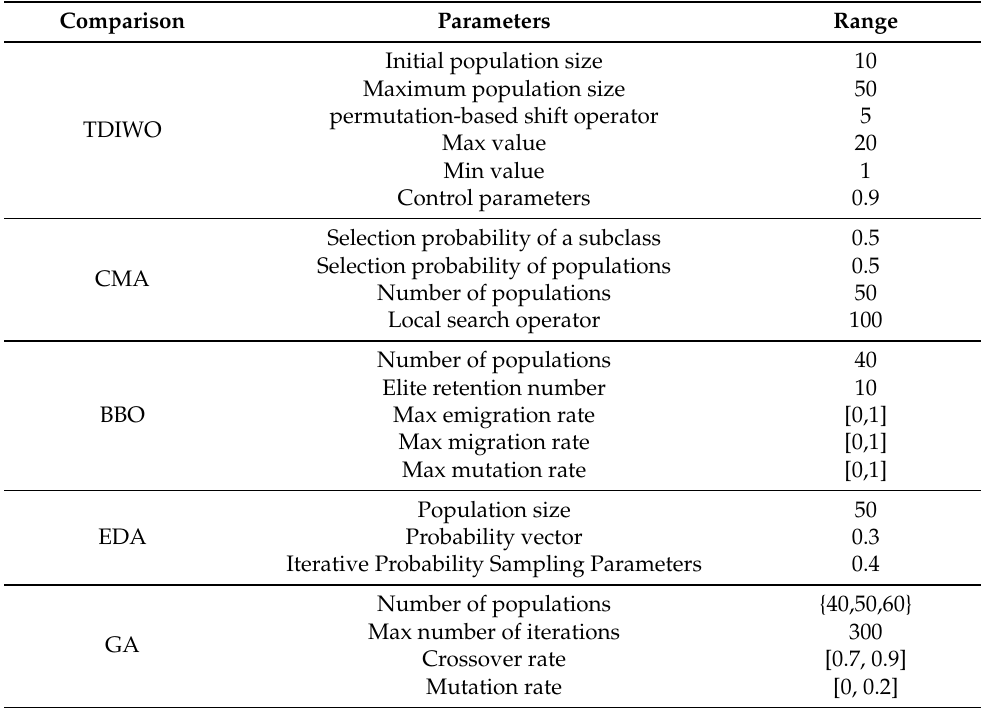
Table 3. Algorithms and